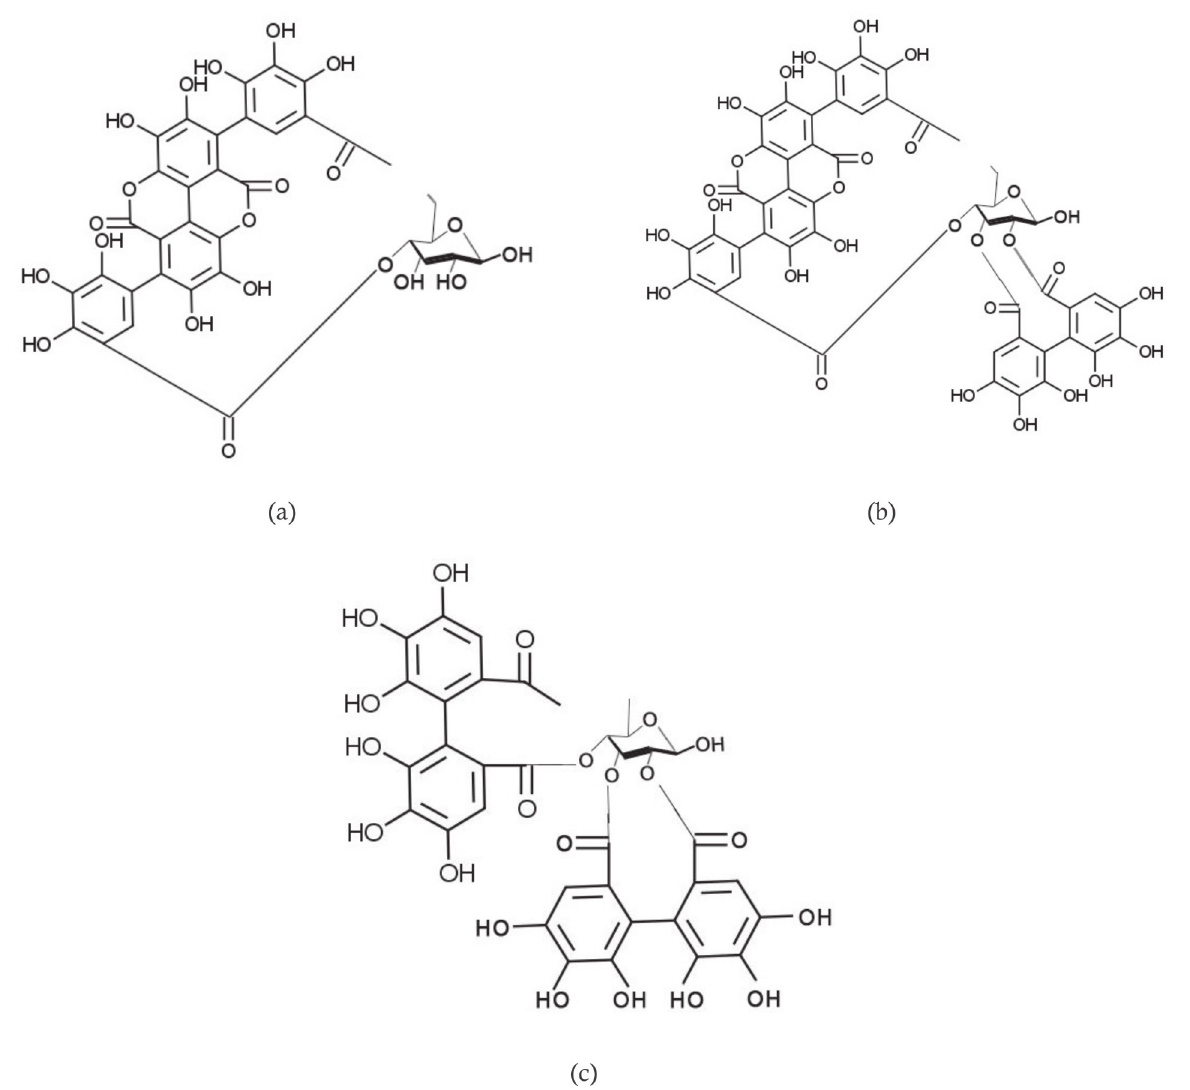
Figure 2. (a) Punikalin’s structure, (b) Punikalagin’s structure, (c) Pedunkulagin’s structure. (Martos et al.,